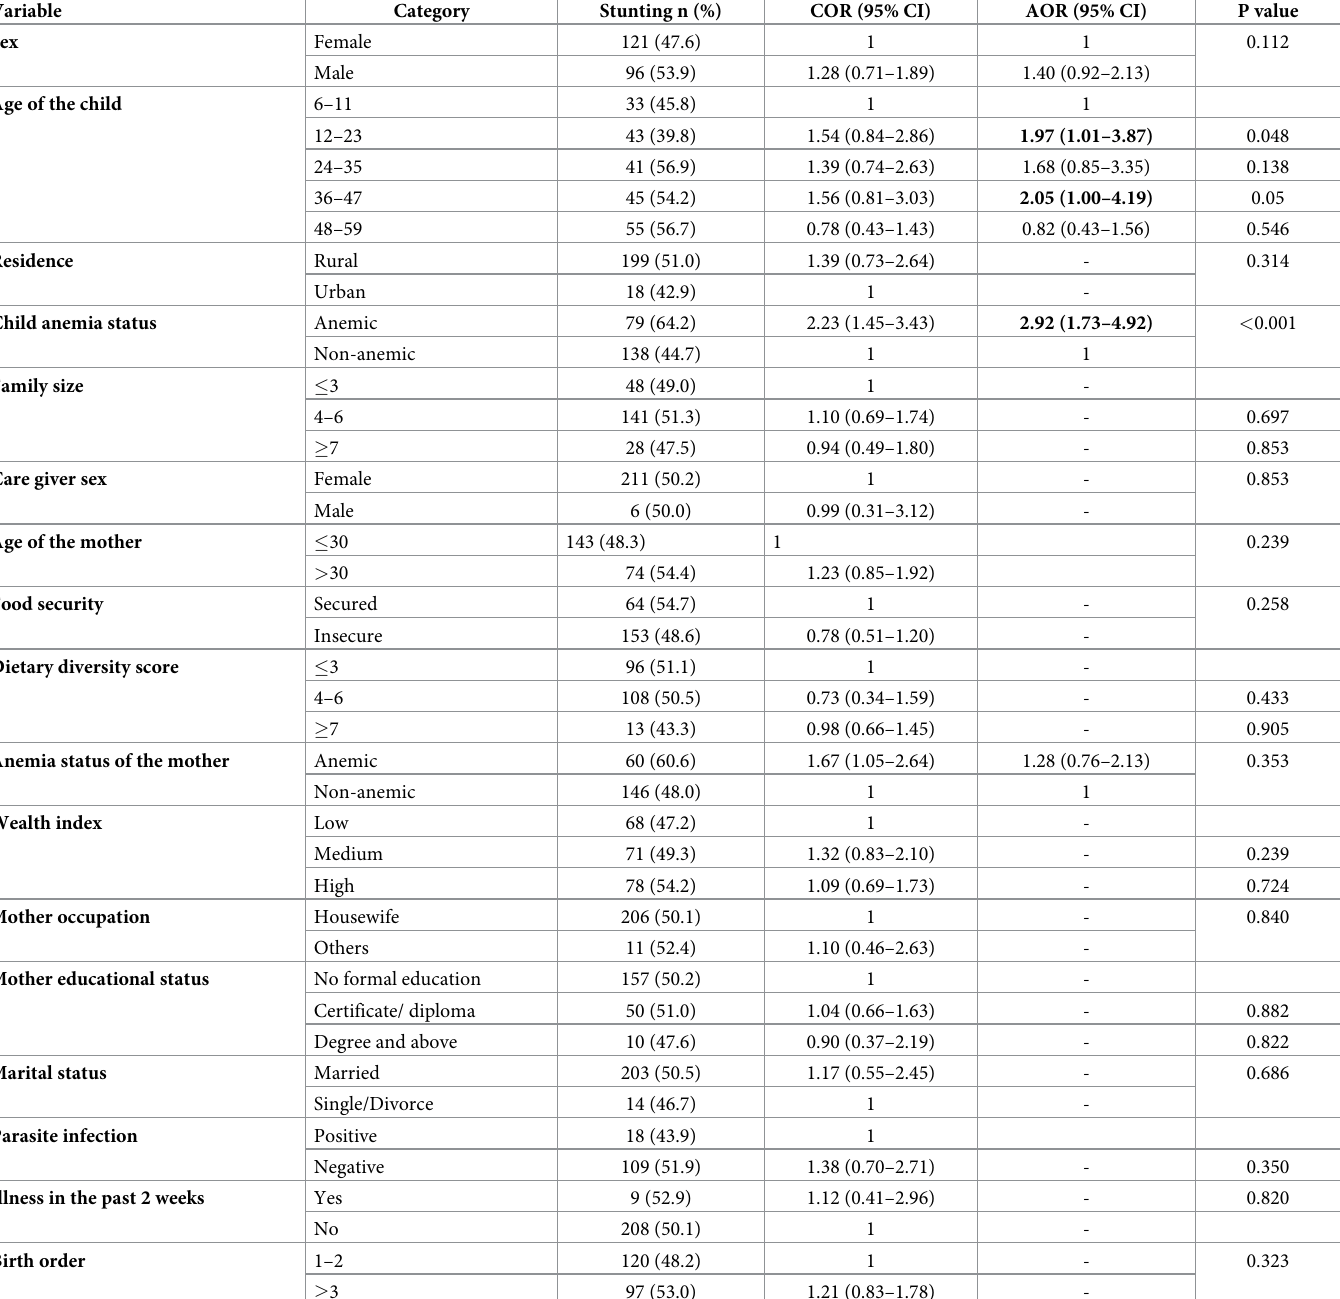
Table 3. Bivariable and multivariable logistic regression analysis of stunting among children aged 6 to 59 months in the Menz Gera Midir district Northeast Ethio- pia in 2021, (N = 432).